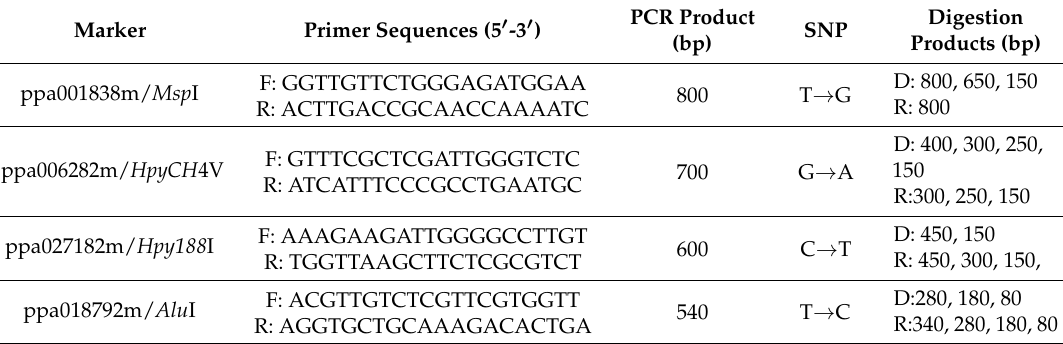
Table 2. Features of the cleaved amplified polymorphic sequence (CAPS) markers developed in this study include the following: primer sequences, estimated length of PCR product, single nucleotide polymorphisms (SNP) generating differential cleavage, and estimated length of digestion products in the parental genotypes Desmayo Largueta (D) and R1000